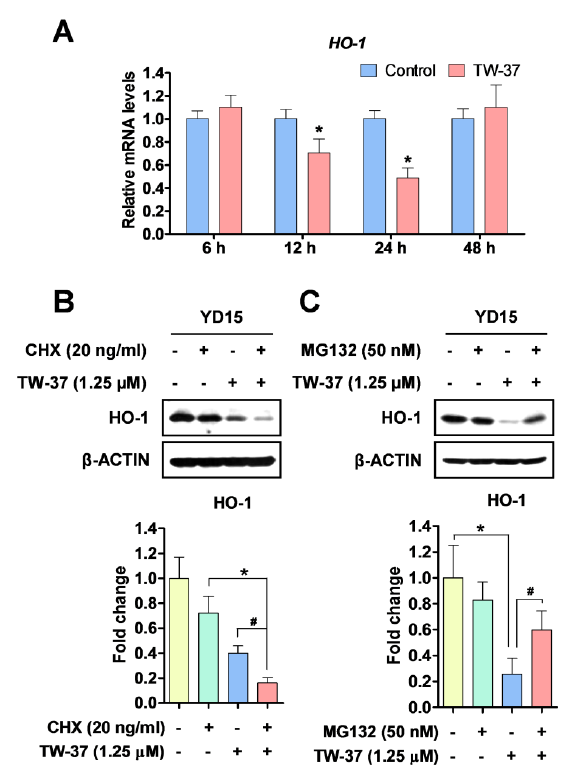
Figure 5. The regulation of HO-1 protein in TW-37-induced apoptosis in YD-15 cells. ( A ) YD-15 cells were treated with DMSO or TW-37 and harvested at the indicated time points (6, 12, 24, and 48 h). HO-1 expression was examined by qPCR and expression was normalized to GAPDH . YD-15 cells were pretreated for 1 h with CHX ( B ) or MG132 ( C ). After 1 h pretreatment, TW-37 or DMSO were added for 24 h. Protein levels of HO-1 was analyzed by western blotting. Bar graphs represent the mean ± SD of three independent experiments. *, p < 0.05 compared with the DMSO-treated group. # , p < 0.05 compared with the TW-37-treated